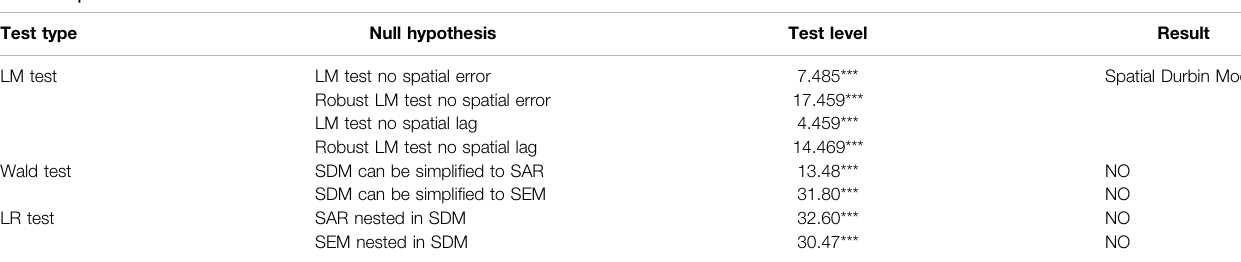
TABLE 10 | The regression results of mediation